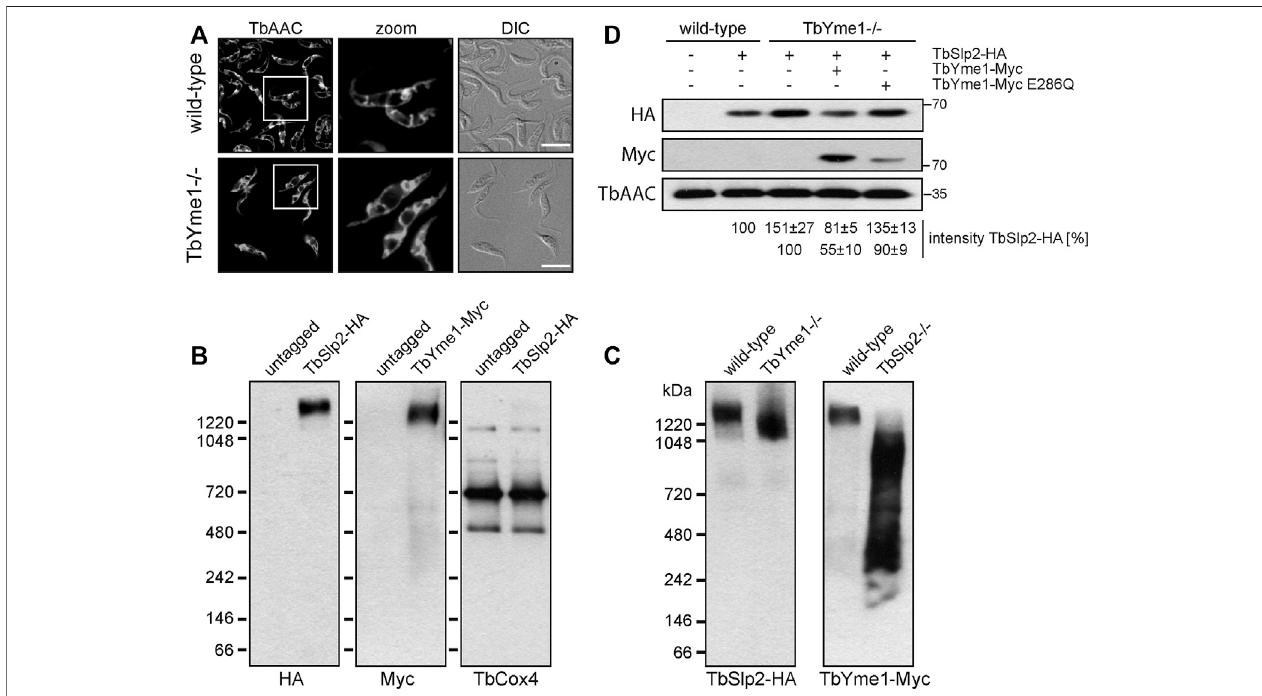
FIGURE 3 | TbSlp2 and TbYme1 form a large complex. (A) Mitochondrial integrity of wild-type and TbYme1 − / − parasites was assessed by immuno fl uorescence microscopy using an antibody against TbAAC. The white box marks the area that is enlarged in the second panel. Scale bar: 10 µm. (B) Native-PAGE and immunoblot analysis of in situ -tagged TbSlp2-HA or TbYme1-Myc expressed in wild-type T. brucei. Untagged parasites were used to control for antibody speci fi city, and TbCox4 wasusedasaloadingcontrol. (C) TbSlp2-HAexpressedinwild-typeandTbYme1 − / − parasites (leftpanel) orTbYme1-Mycexpressedinwild-typeandTbSlp2 − / − parasites (right panel) wereanalysedbynative-PAGEand immunoblottingusingHAorMycantibodies,respectively. (D) Quanti fi cation byimmunoblottingofTbSlp2- HA expressed in wild-type, TbYme1 − / − or TbYme1 − / − parasites re-expressing TbYme1-Myc or TbYme1-Myc E286Q. Proteins were quanti fi ed relative to TbAAC and intensity values are given below the blot (n ≥